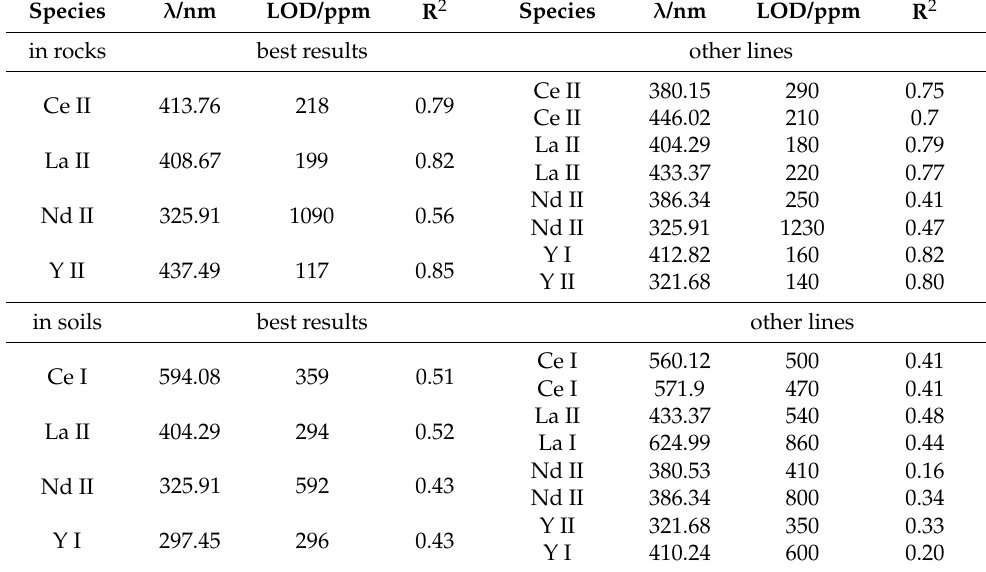
Table 3. Results of univariate regression of field samples of REE (Ce, La, Nd, Y) in rocks and soils: wavelength, LOD and R 2 of best and other analyzed REE